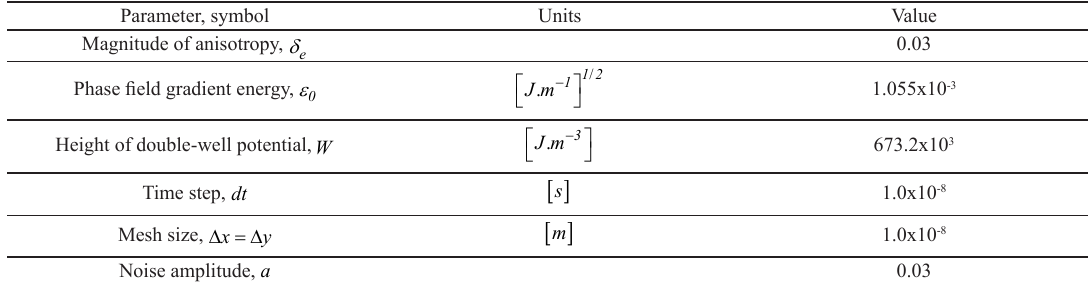
Table 2 – Phase field computational